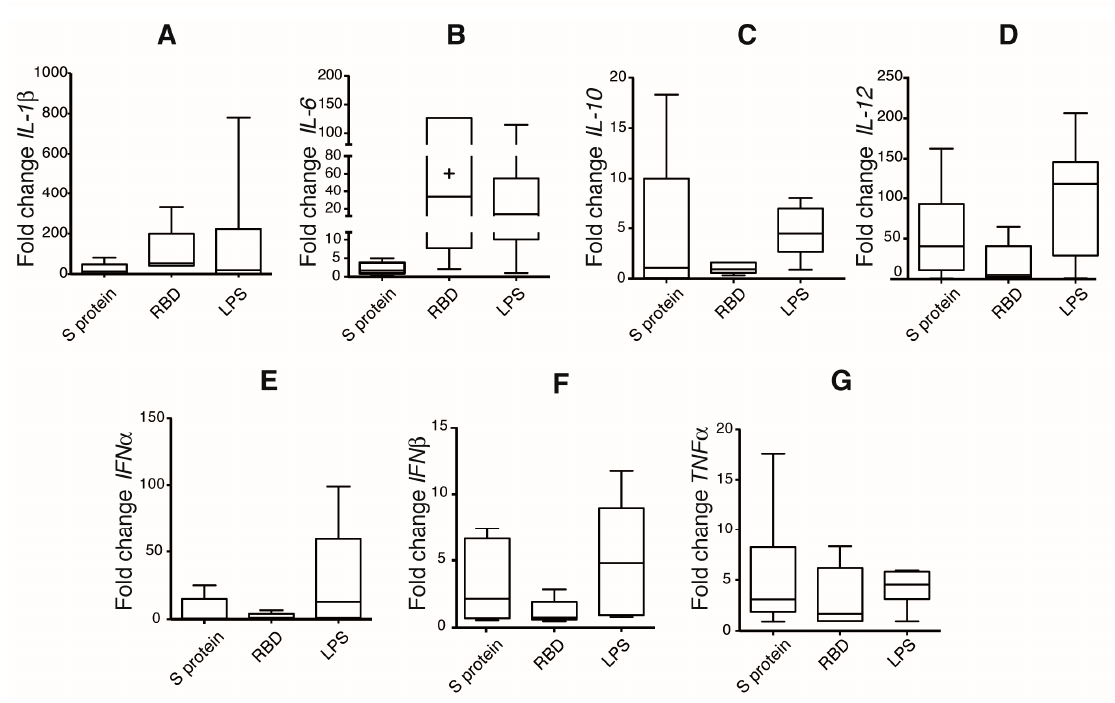
Figure 3. Spike protein and RBD of SARS-CoV-2 induce a proinflammatory activation program in iDCs. Cells were incubated with indicated stimulus for 24 h; relative gene expression of different cytokines was evaluated by real-time PCR and normalized to the basal condition. Relative expression of IL-1 β ( A ), IL-6 ( B ), IL-10 ( C ), IL-12 ( D ), IFN α ( E ), IFN β ( F ), and TNF α ( G ), is shown. n = 6 donors for iDC, Spike, and LPS conditions; n = 5 donors for